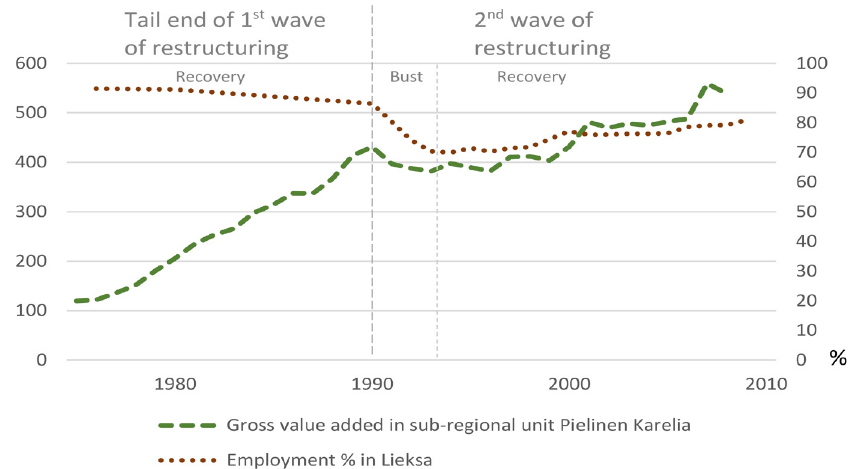
Fig. 3. Gross value added of output and employment 1 in sub-regional unit Pielinen Karelia and employment %, employed % of the labour force 2 in Lieksa (sources: Lieksa 1980; Statistics Finland 1982, 2010,